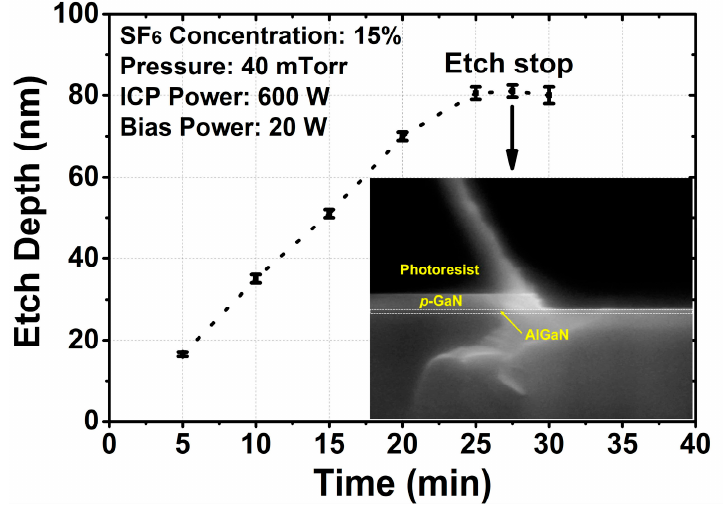
Figure 5. p -GaN etch depth as a function of time; the inset X-SEM image of sample with 2.5 min of overetching.